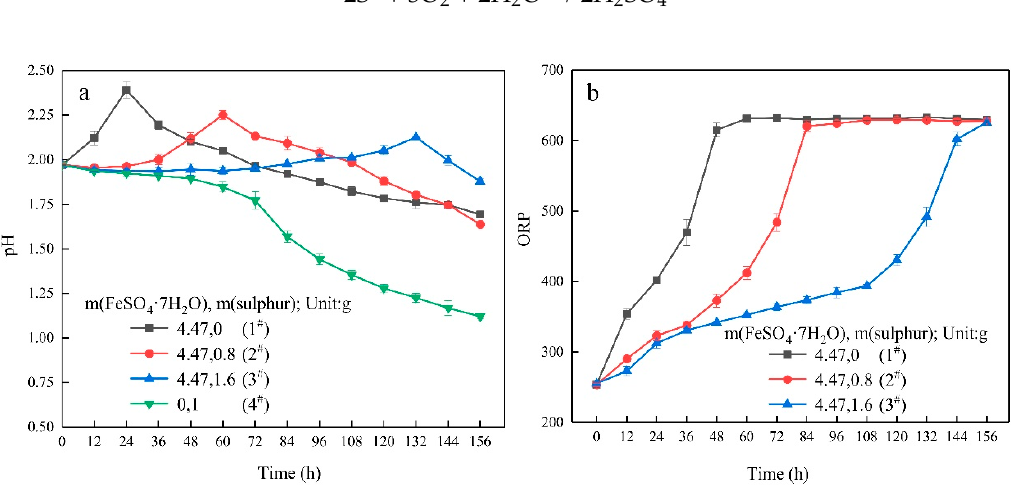
Figure 3. A graph of pH ( a ) and oxidation-reduction potential (ORP) ( b ) over time from experimental systems.